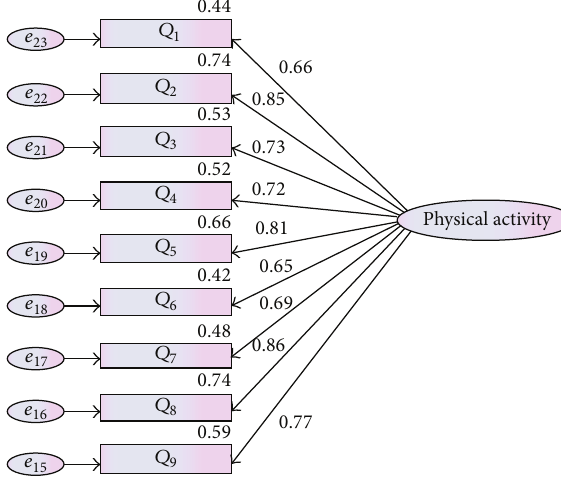
Figure 5: Measurement model for physical activity.